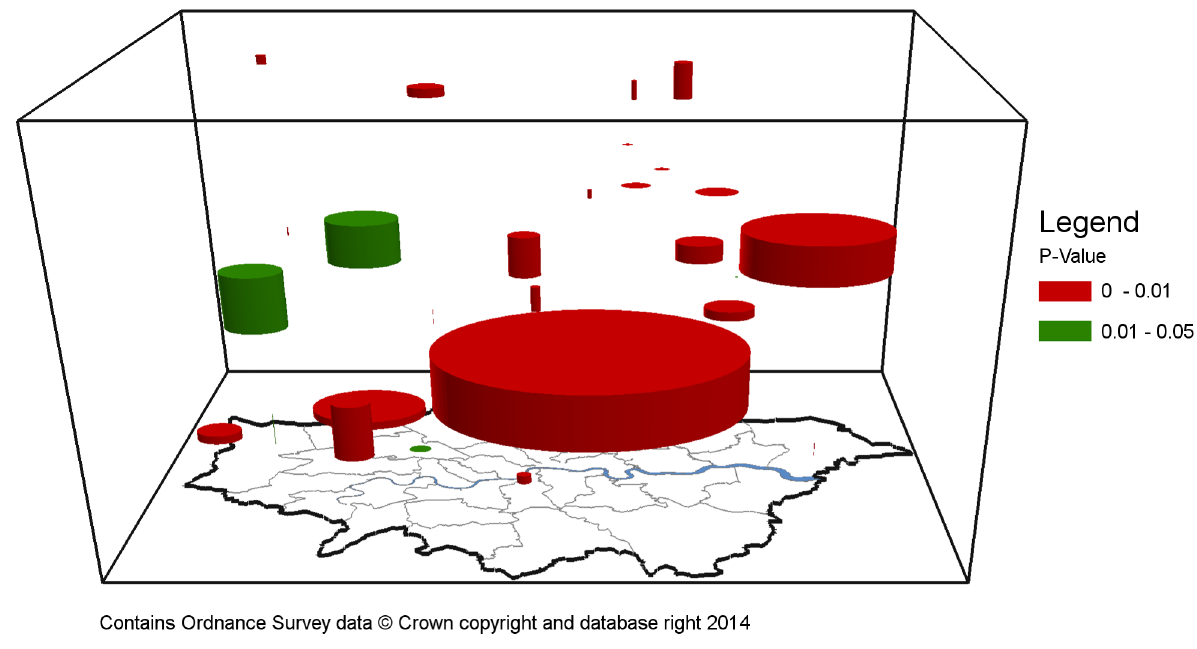
Figure 3. Significant hourly clusters within London between 16th January and 17th January 2013. doi:10.1371/journal.pone.0097807.g003 PLOS ONE |